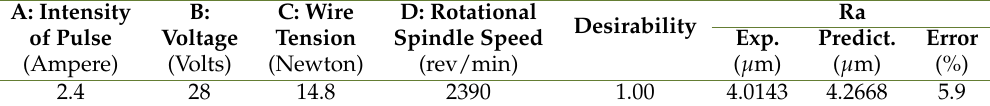
Table 5. Optimal solutions generated for minimizing surface